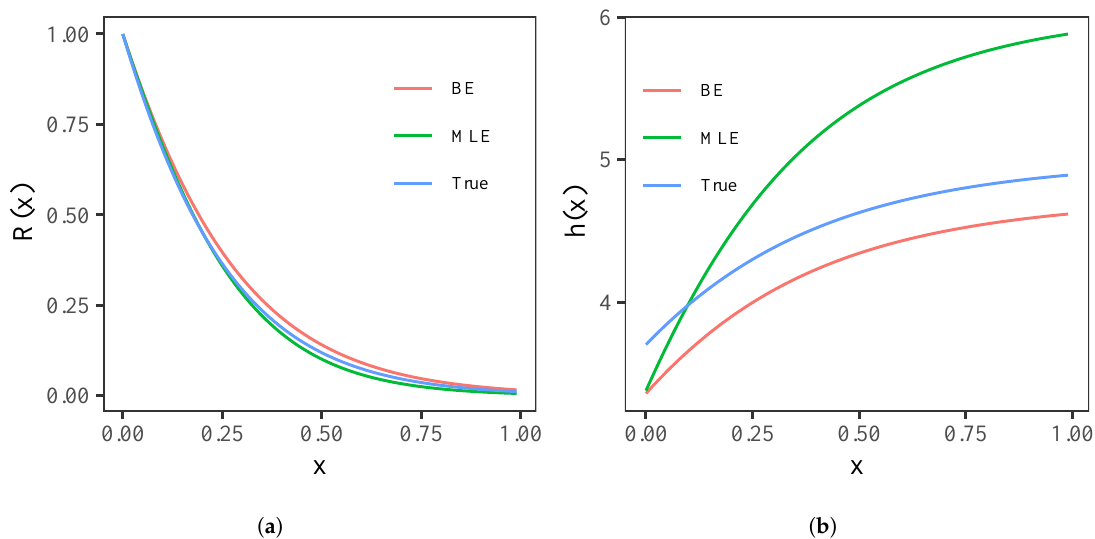
Figure 3. ( a ) Point estimates of R ( x ) ( left ) and ( b ) h ( x ) ( right ) for the simulated